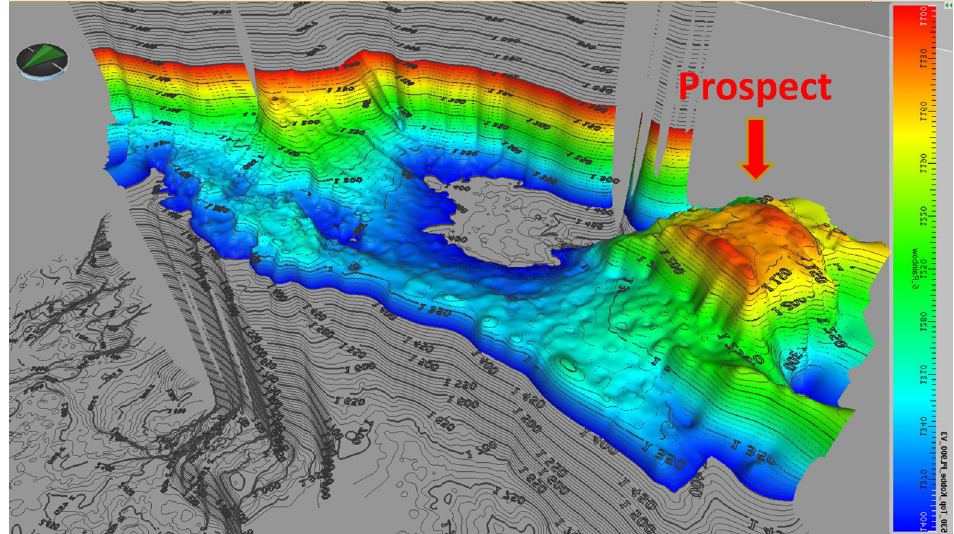
Fig. 6. – Interpreted subsurface image pointing out a trap or closure